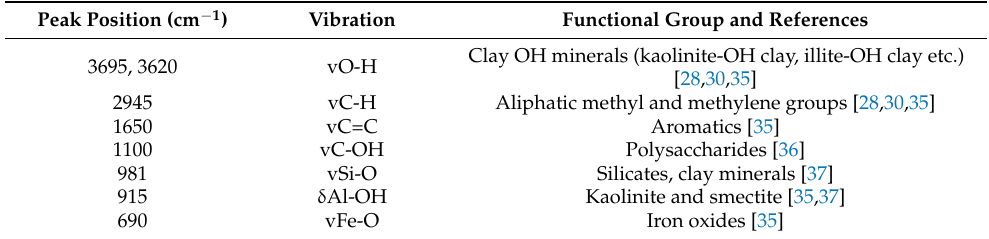
Table 2. Representative functional groups of the main SR-FTIR spectrum from the